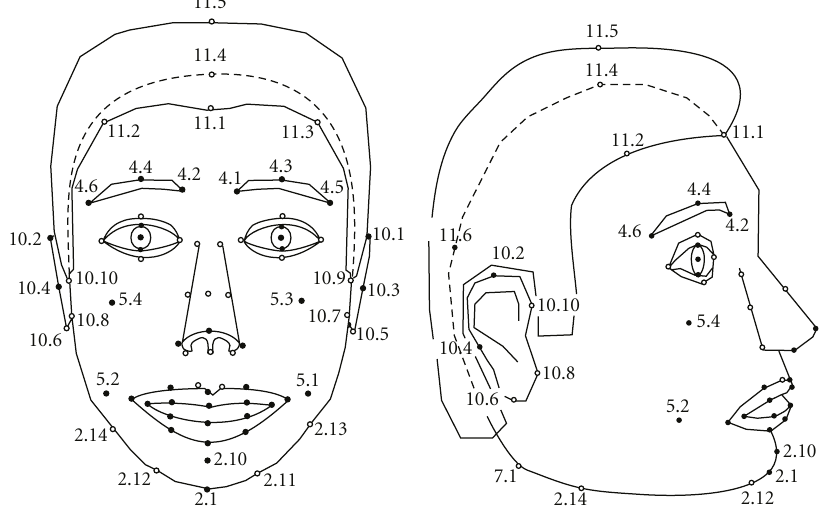
Figure 11: MPEG-4 feature points.